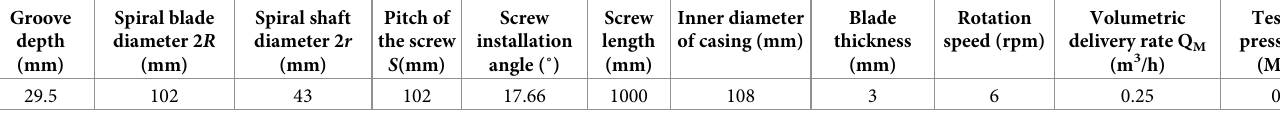
Table 1. Parameters of the model screw